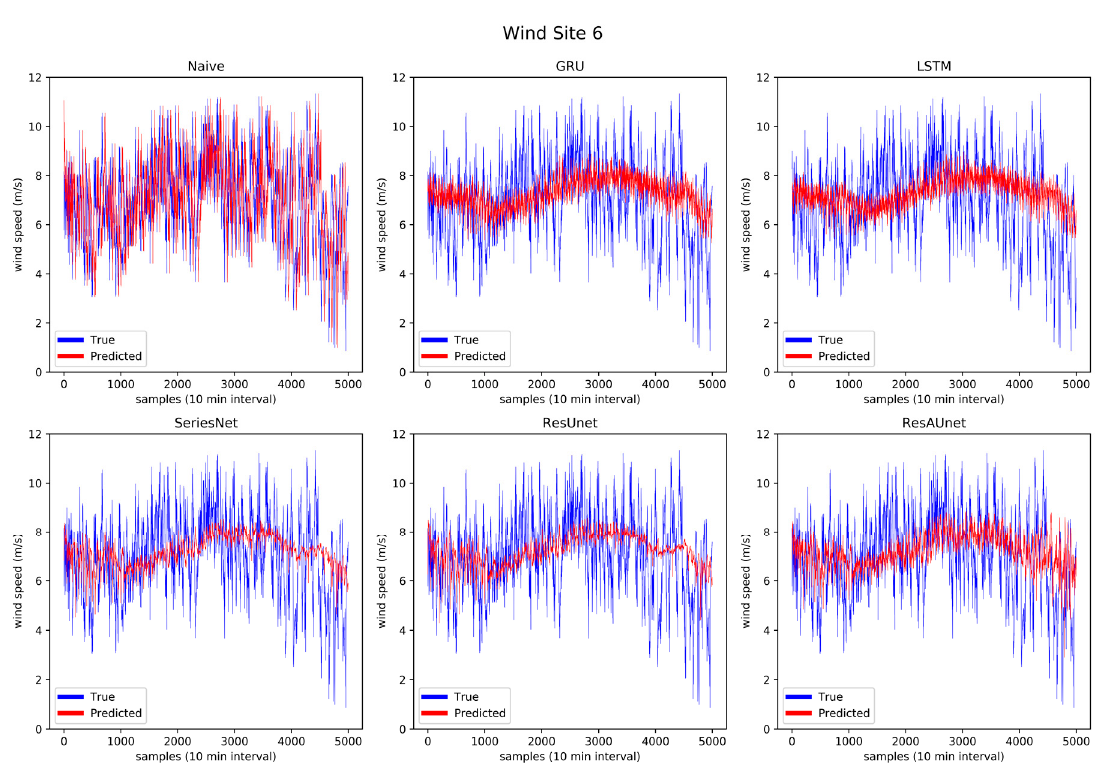
Figure 18. Prediction results of the six models for wind Site 6.